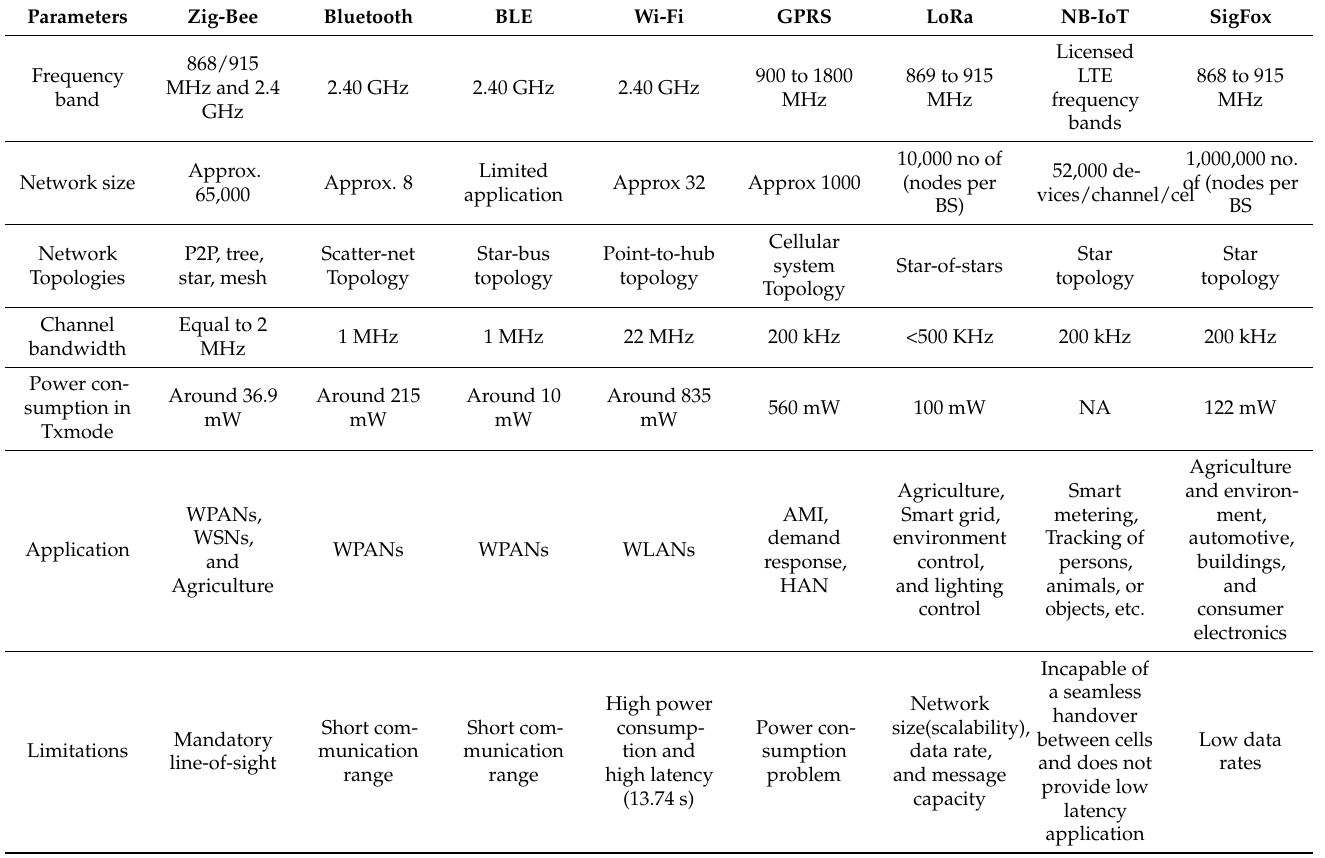
Table 1. Technical specifications of communication protocols